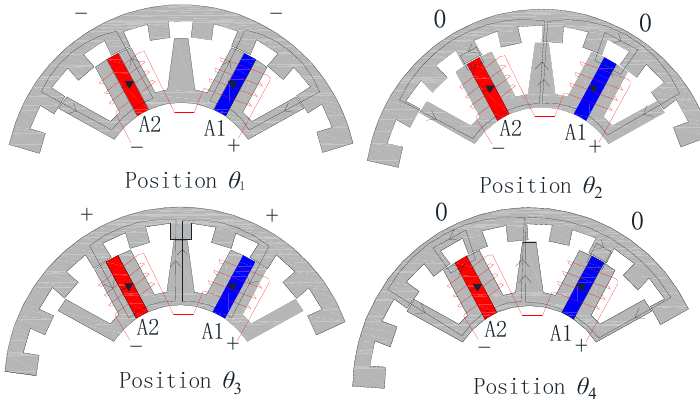
Figure 2. Distributions of the main magnetic flux lines in module M A .